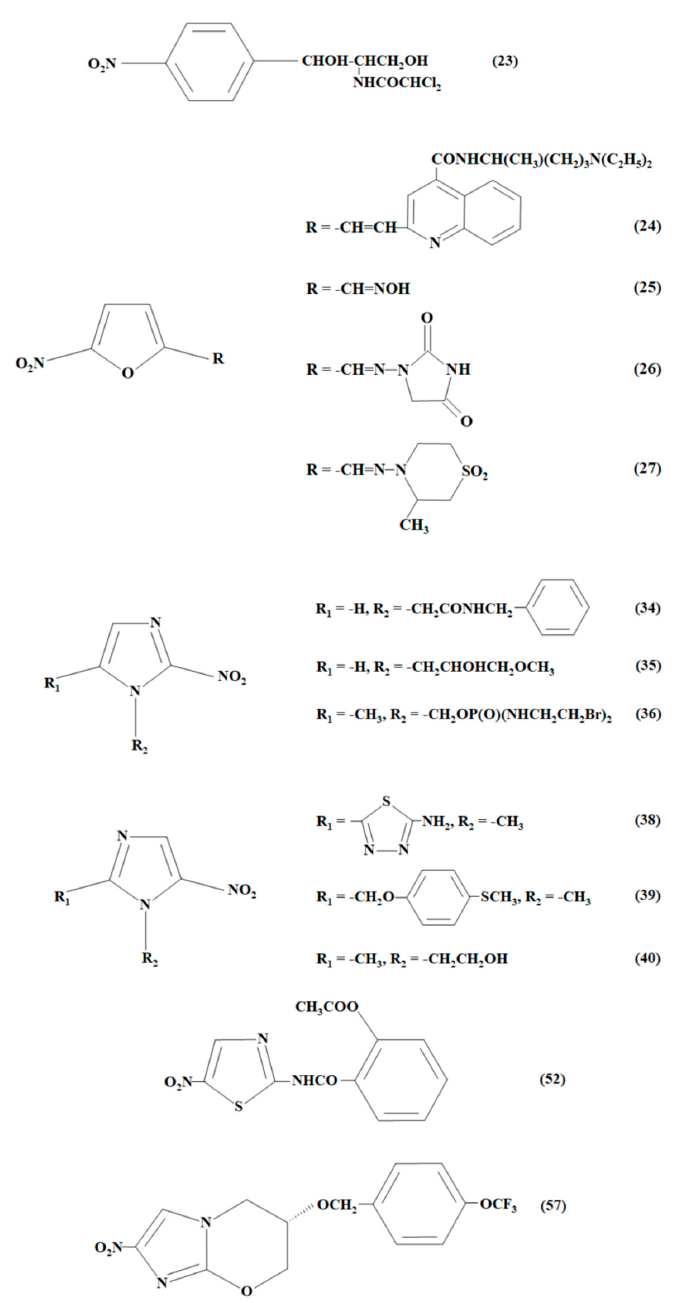
Figure 1. Formulas of nitroaromatic antibacterial and antiparasitic agents: chloramphenicol ( 23 ), chinifur ( 24 ), nifuroxime ( 25 ), nitrofurantoin ( 26 ), nifurtimox ( 27 ), benznidazole ( 34 ), misonidazole ( 35 ), TH-302 ( 36 ), megazol ( 38 ), fexinidazole ( 39 ), metronidazole ( 40 ), nitazoxanide ( 52 ), and PA-824 ( 57 ). The numbers of compounds correspond to those in Table A1 (Appendix A).